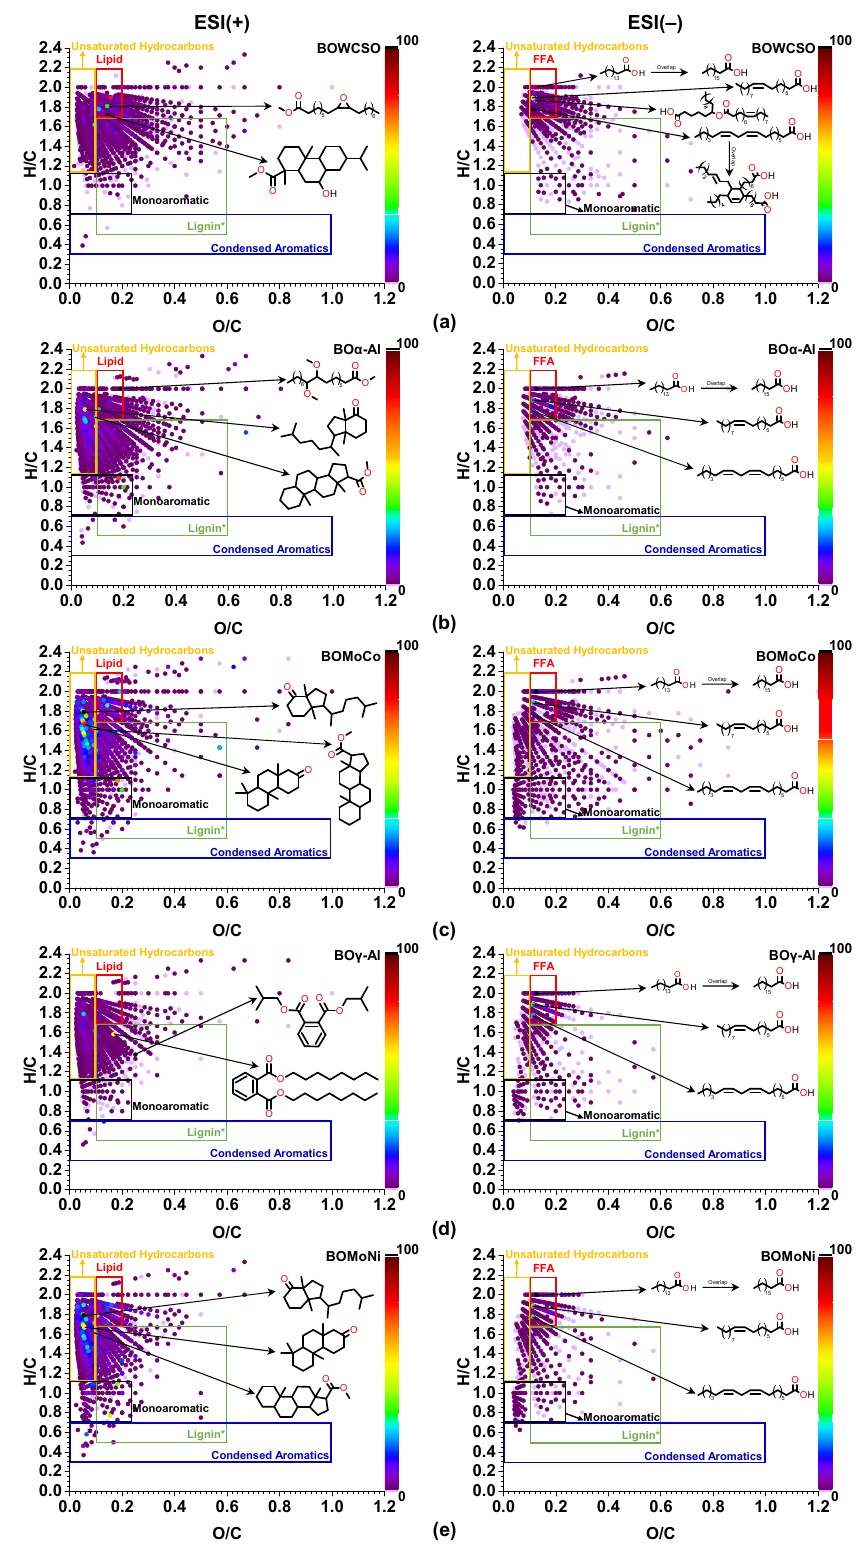
Figure 8. The van Krevelen plot for all bio-oils with C x H y O z molecules, with ( a ) z = 1–7 in the ESI(+) and z = 2–6 in the ESI( − ), ( b ) z = 1–6 in the ESI(+) and z = 2–6 in the ESI( − ), ( c ) z = 1–5 in the ESI(+) and z = 1–6 in the ESI( − ), ( d ) z = 1–5 in the ESI(+) and z = 1–4 in the ESI( − ), ( e ) z = 1–5 in the ESI(+) and z = 1–4 in the ESI( − ). Colors purple to black indicate the intensity from 0 to 100.